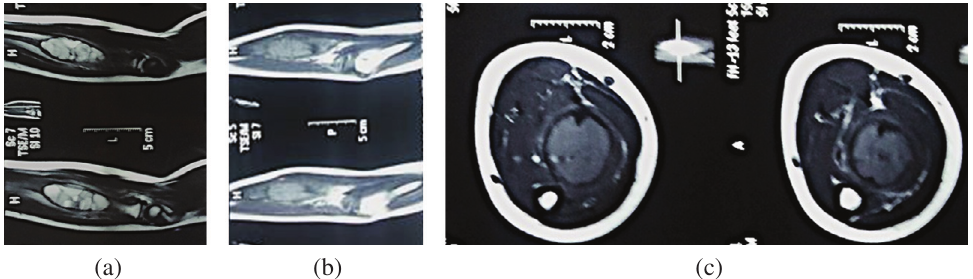
Figure 3. (a) T2 weighted sagittal MR images showing meta-diaphyseal expansile lesion with multiple hyperintense cysts with fluid-fluid levels and surrounding complete hypointense rim, (b) T1 weighted sagittal MR images showing iso to hypointense lesion, (c) T1 weighted sagittal MR images showing well marginated expansile iso to hypointense